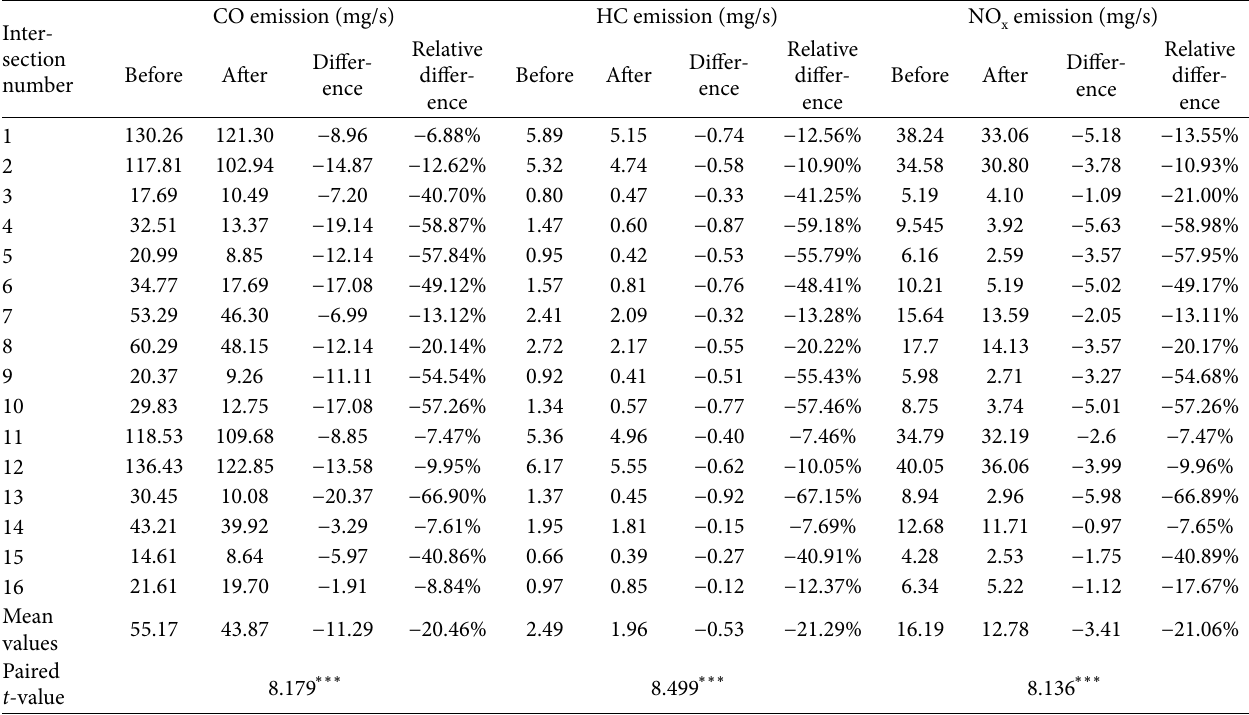
Note : The difference is equal to the emission after setting one-way traffic management subtracted by the emission before one-way traffic management. ∗∗∗ denotes significance in the 99% confidence level.